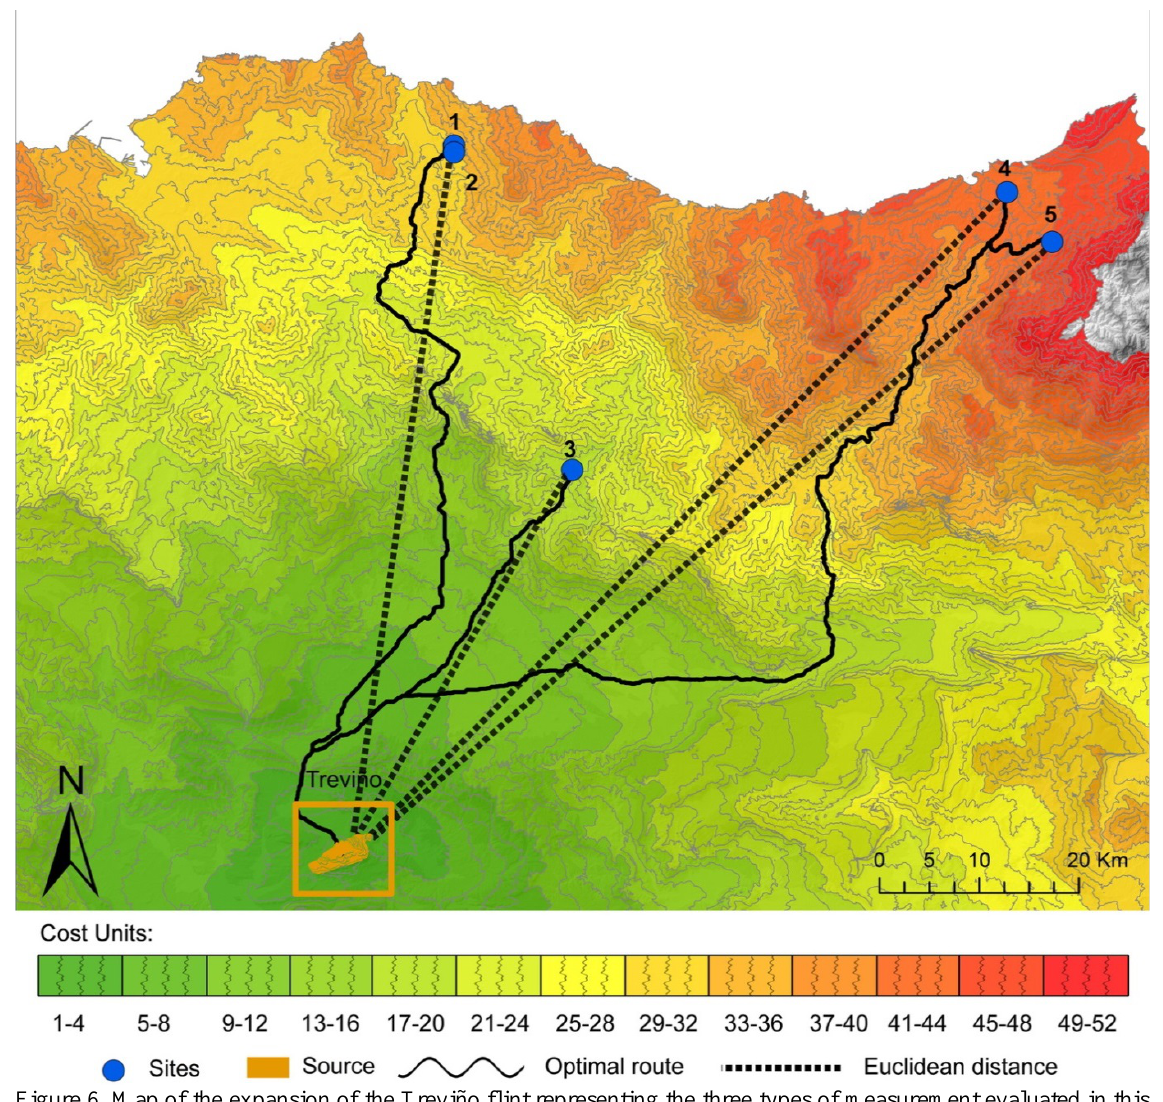
Figure 6. Map of the expansion of the Treviño flint representing the three types of measurement evaluated in this paper: Euclidean distance, the distance through the optimal route and cost. Legend: 1. Antoliñako Koba, 2. Santimamiñe, 3. Labeko Koba, 4. Ametzagaina and 5. Aitzbitarte